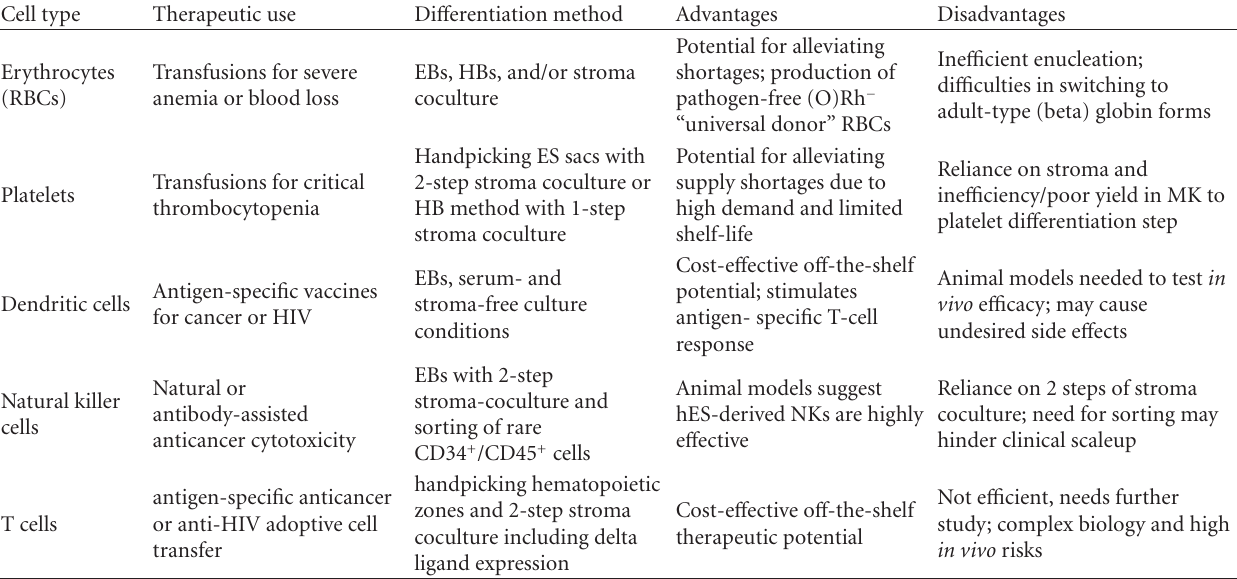
Table 1: Utility and current status of hESC/iPSC-derived blood